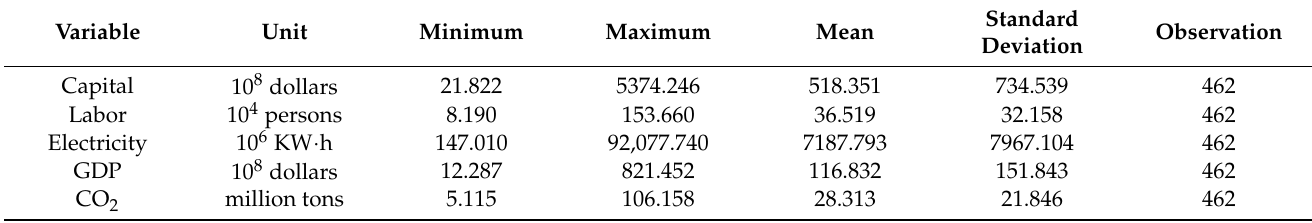
Table 1. Data characteristics of the input–output variables of northeast China in